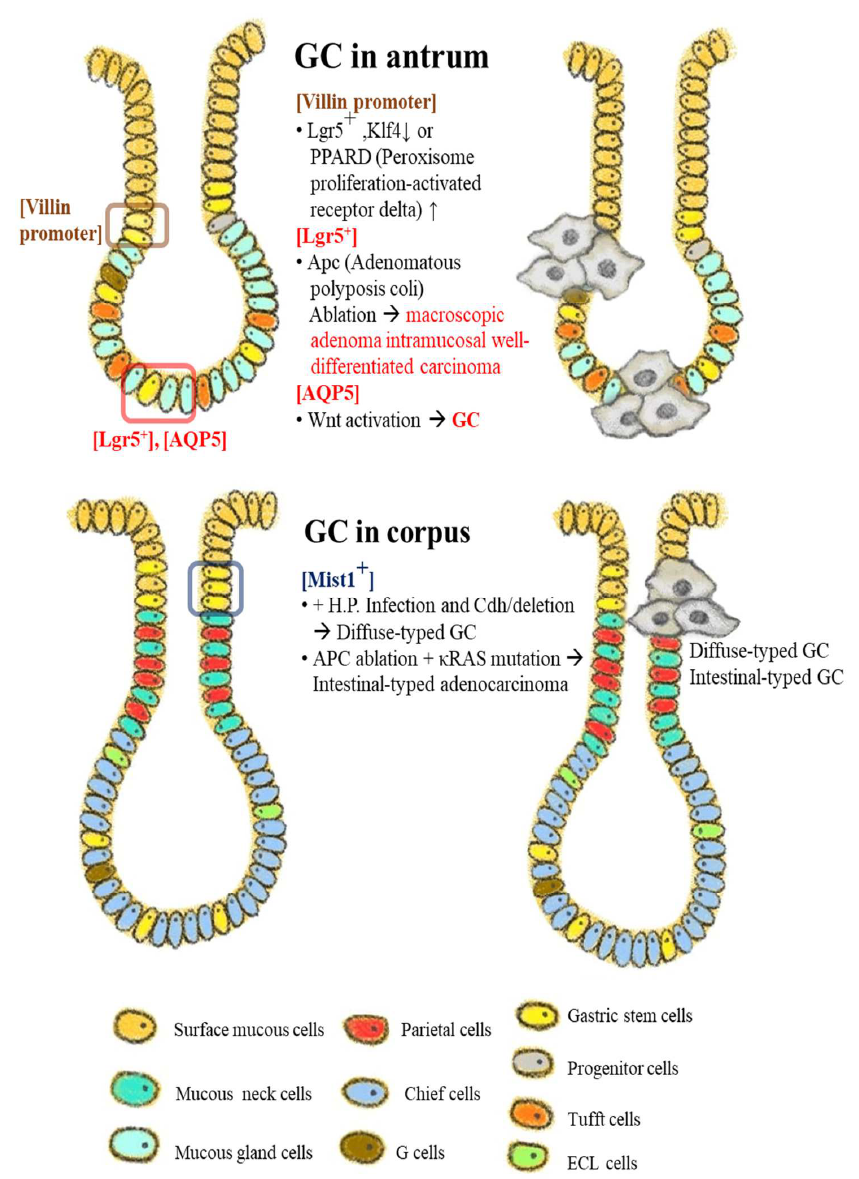
Figure 2. Schematic models of gastric stem cells and their specific markers in gastric carcinogenesis. The stem cell candidates or their origins specified by the respective markers were activated by the promoter activation, signaling activation, mutation, and ablation/deletion of the putative oncogenes to induce the gastric cancers in antrum and corpus regions. In antrum GC, light blue color indicates the mucous gland cells, and in corpus GC, medium blue-green color and blue color indicate the mucous neck cells and chief cells, respectively. Brown boxed area and red boxed area indicate the localized sites of villin promoter in the antrum region and the Lgr5/AQP active locus in the corpus region. This figure was modified from the original versions with permission from Hayakawa et al. [12], Stem cells and origins of cancer in the upper gastrointestinal tract; published by Cell stem cell, 2021 (5279230068983).